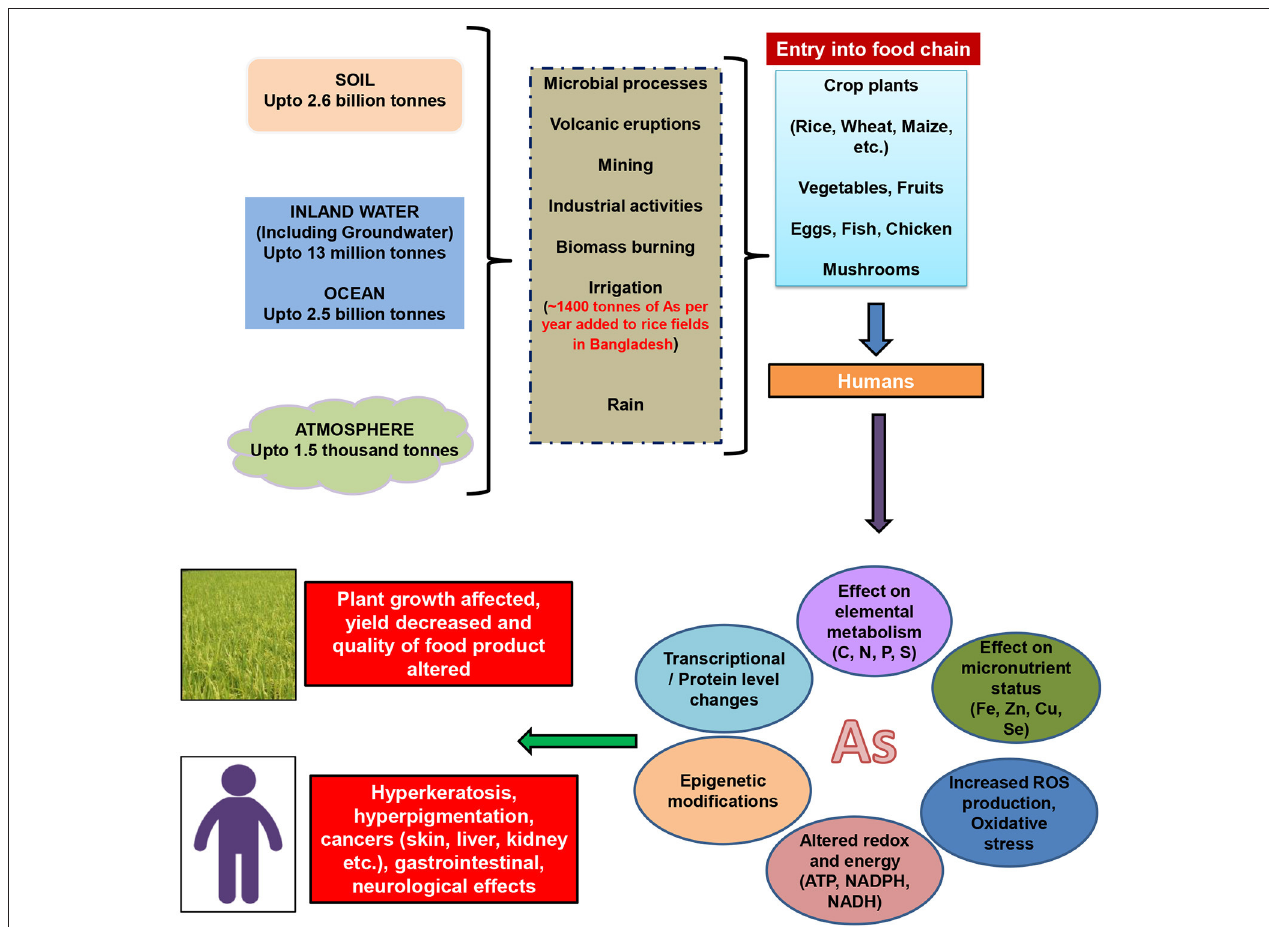
FIGURE 1 | The figure represents the presence of As in soil, water, and air and the entry routes of As to plants, animals and humans via irrigation, volcanic eruptions, mining and industrial activities, microbial processes and rain. Once inside plants and humans, the toxicity mechanisms include elemental interactions, reactive oxygen species (ROS) production, oxidative stress induction, redox and energy imbalance, and epigenetic, transcriptional and proteomic changes. Prolonged exposure to As leads to diminished growth, and yield in plants and to various medical problems, including cancers in humans. (As values for soil, inland water, ocean, and atmosphere and irrigation water taken from Neumann et al. (2011) and Sohn